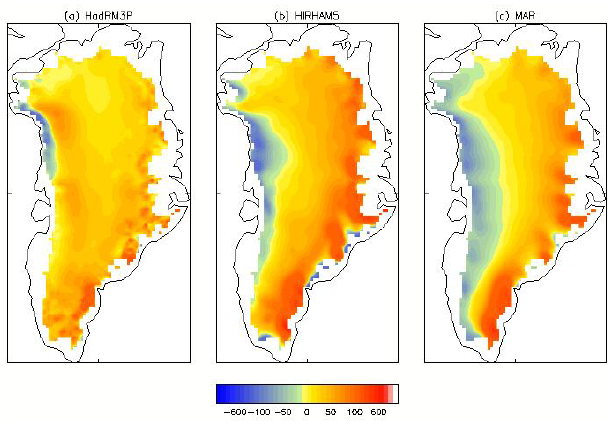
Fig. 14. GrIS snowfall anomalies: 2080–2099 means from ECHAM5-A1B-forced simulations, relative to 1980–1999 means from recent-past ECHAM5-forced simulations: (a) HadRM3P, (b) HIRHAM5, and (c)